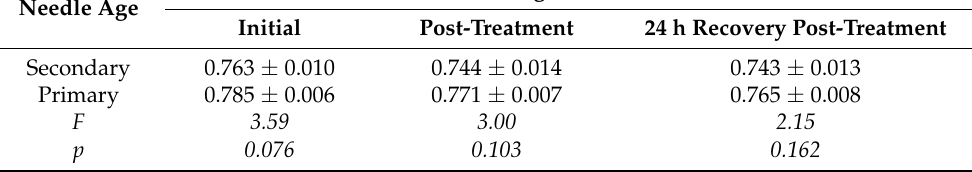
Table 3. Effects of freezing assay ( − 10 ◦ C during 30 min) on the Fv/Fm of secondary and primary needles. Values are the average ± SE ( n = 9). Non-significant differences between secondary and primary needles were found after one-way ANOVA ( p < 0.05). Corresponding F and p values are shown in